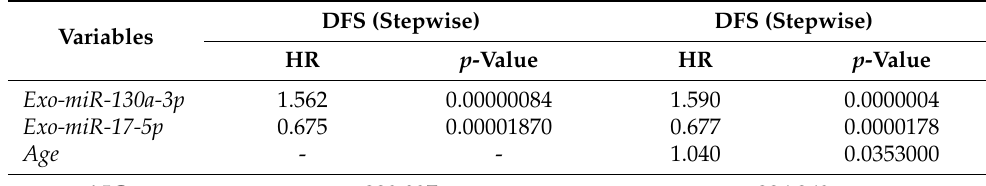
Table 4. Coefficients and relative p -values of the stepwise multivariable Cox regression model obtained from the combination of 8 Exo-miRs obtained by ddPCR (n = 63), without and with clinical variables. AIC (Akaike Information Criterion) values of the models are reported.